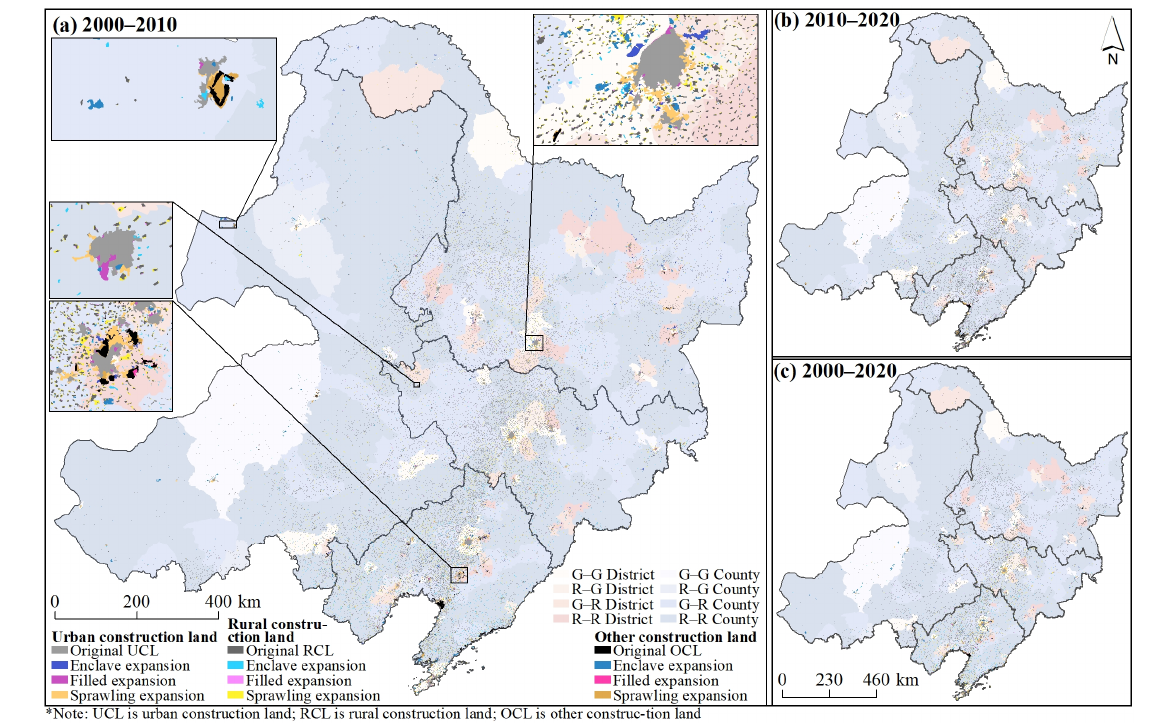
Figure 8. Spatial patterns of construction land expansion in northeast China. ( a ) 2000–2010; ( b ) 2010–2020; ( c ) 2000–2020.